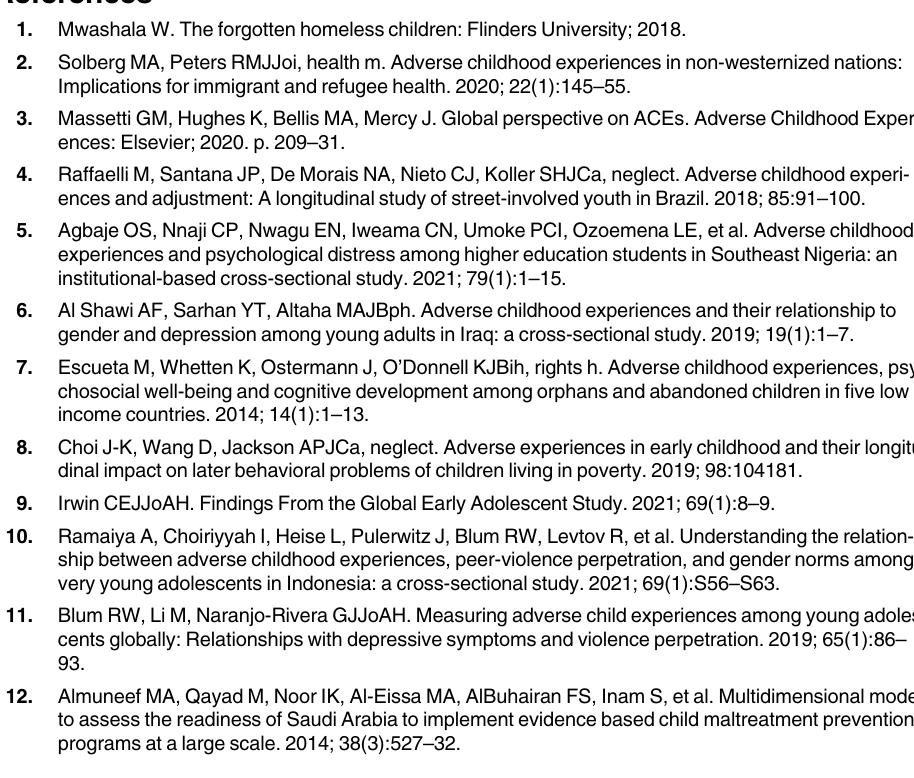
S6 Table. (Proposed for) rapid assessment of the biopsychosocial dimension of childhood adversity associated with